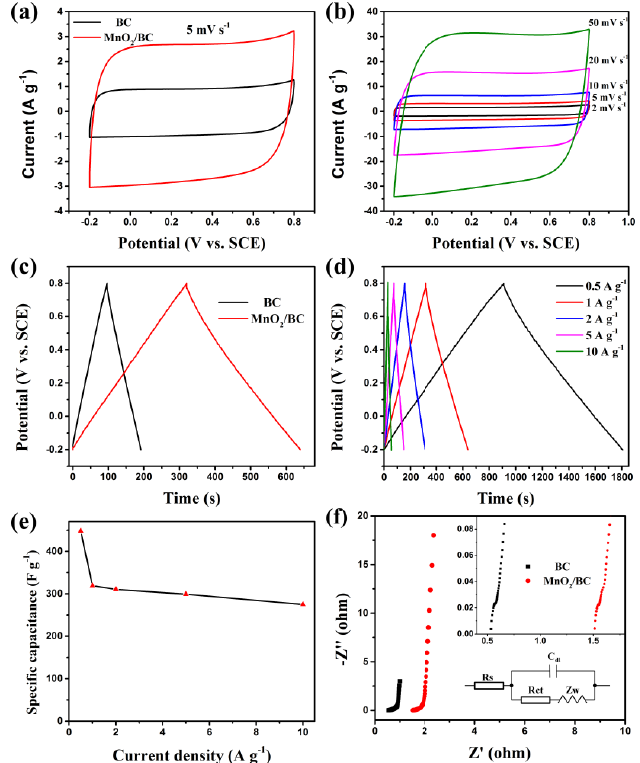
Figure 6. ( a ) The CV curves of BC and MnO 2 /BC electrodes at a scan rate of 5 mV s −1 in 1 M of Na 2 SO 4 , ( b ) the CV curves of the MnO 2 /BC electrode at different scan rates, ( c ) GCD curves of BC and MnO 2 /BC electrodes at a current density of 1 A g −1 , ( d ) GCD curves of the MnO 2 /BC electrode at different current densities, ( e ) specific capacitance of MnO 2 /BC electrode at different current density, ( f ) EIS of the BC and MnO 2 /BC electrode (The inset shows the expanded high-frequency region of Nyquist plots).